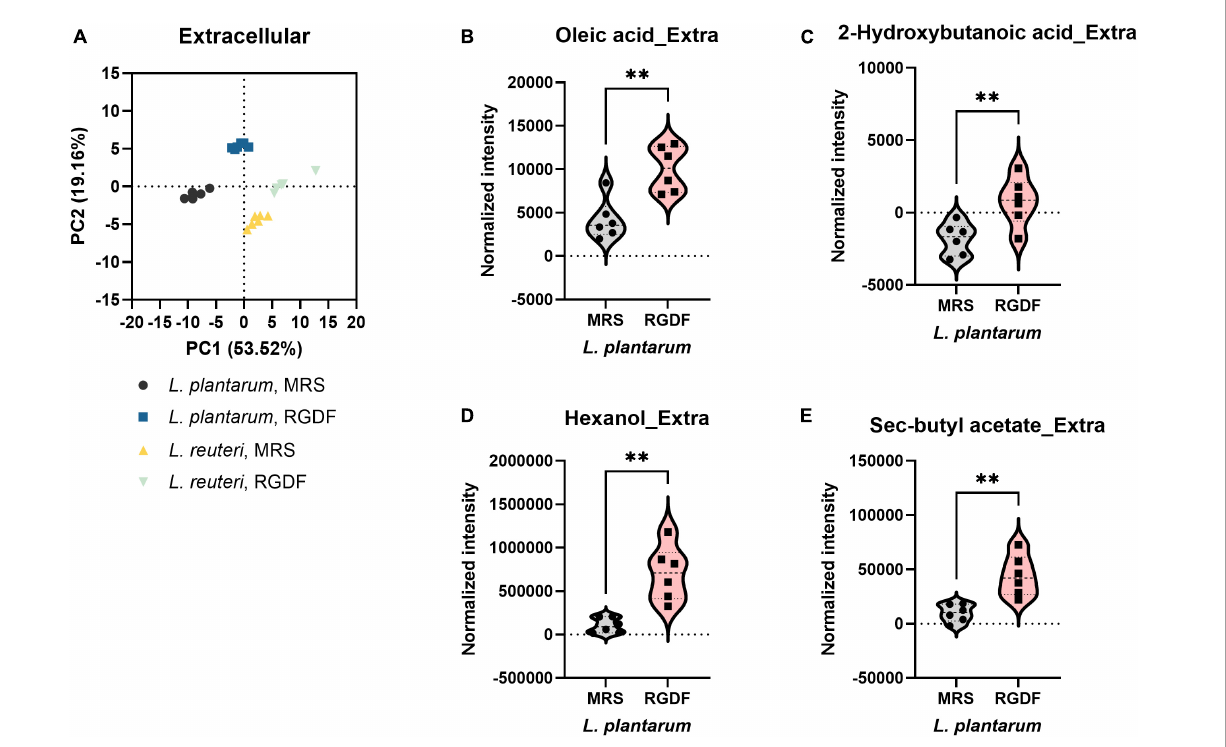
FIGURE4 Extracellular metabolomic analysis of L. plantarum and L. reuteri cultured with 0.5% (w/v) RGDF compared to the control MRS broth. (A) Principle component analysis (PCA) score and loading plots. Normalized abundance of intracellular metabolites of L. plantarum (B–E) cultured with 0.5% (w/v) RGDF compared to the control MRS broth. Data are expressed as violin plots of six determinations. Differences between metabolite abundances were all significant at a significance level of 95% ( ∗ ) and 99% ( ∗∗ ), as determined by the Student’s t